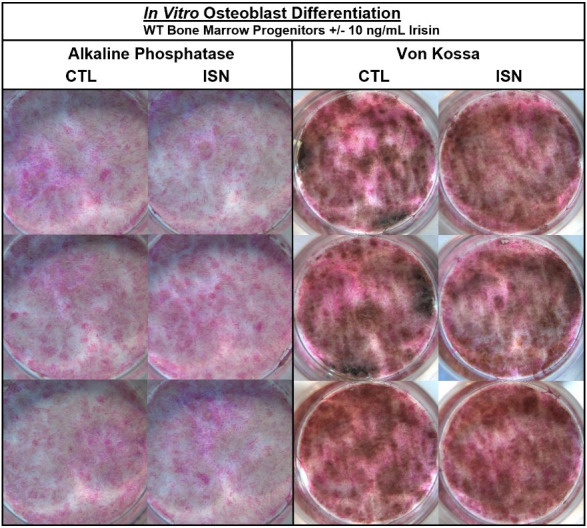
Representative images of in vitro osteoblast cultures with (ISN) or without (CTL) 10 ng/mL irisin during 18-day differentiation.Alkaline phosphatase and von Kossa staining show no qualitative effect of irisin on differentiation or mineralization, respectively.